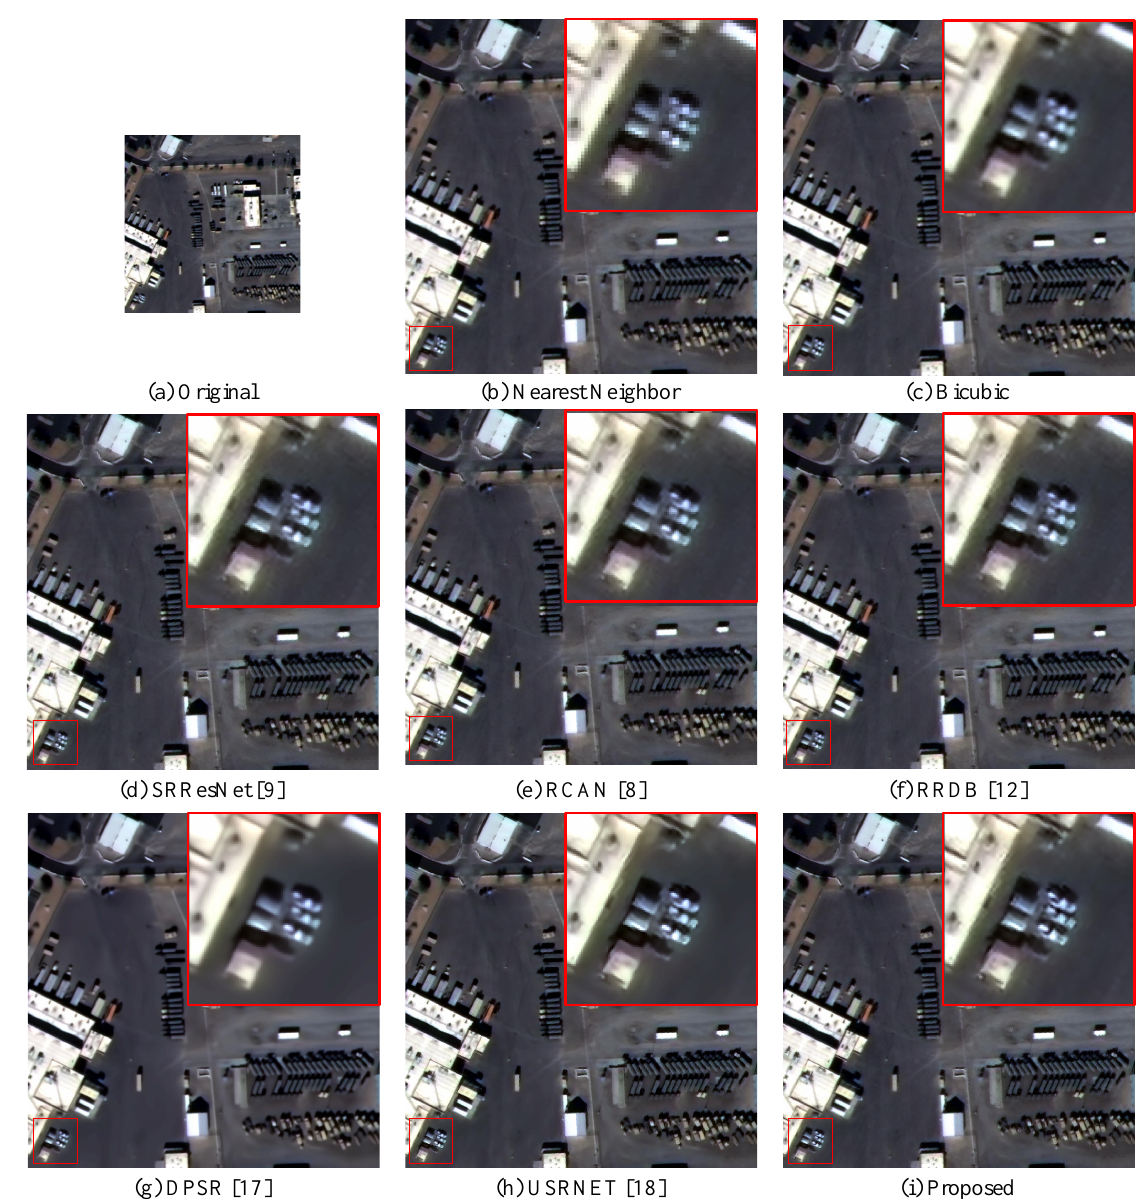
Figure 11. Visual qualitative comparisons of the proposed method with other SR methods on pansharpened KOMPSAT-3 image, North Las Vegas Readiness Center,